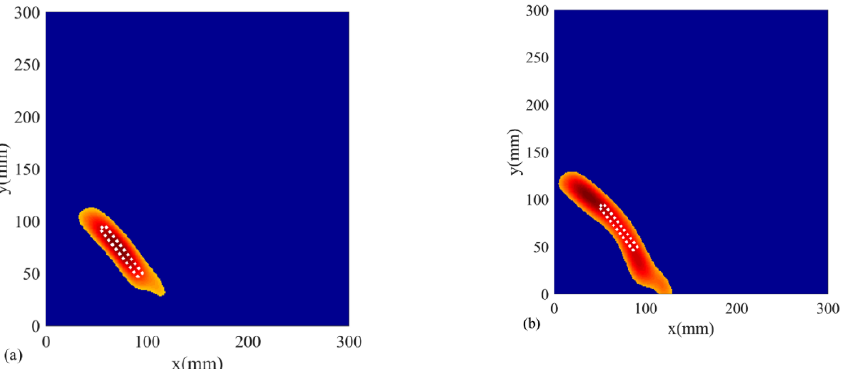
Figure 11. The damage image generated with a changed group velocity of Lamb wave A 0 mode at 120 kHz: ( a ) the image generated with a group velocity of 2.8 m/ms; ( b ) the image generated with a group velocity of 3.0